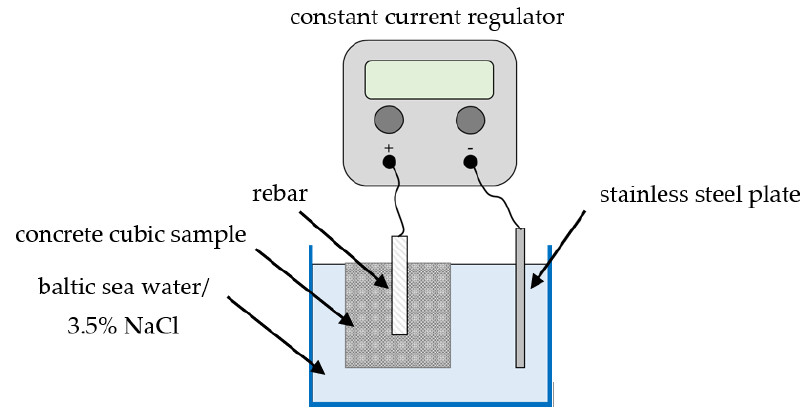
Figure 5. Schematic illustration of the experimental set-up for corrosion stimulation.